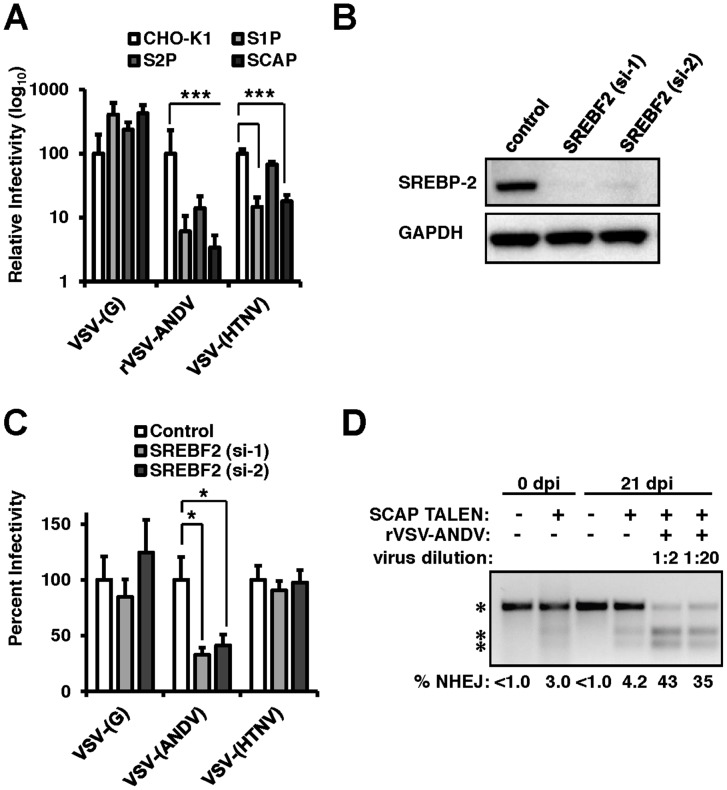
The sterol regulatory complex promotes infection of ANDV.(A) Infection of Chinese Hamster Ovary (CHO) cells null for S1P, S2P, or SCAP (Figure S2). CHO cells were infected with VSV-(G), rVSV-ANDV or rVSV-HTNV for 10 hours. Infections were quantified via flow cytometry and normalized relative to wild-type (CHO-K1) cells. Mean±SEM shown for three independent experiments; *** p<0.001. (Raw infection percentage (CHO-K1): VSV-(G) = 21%, rVSV-ANDV = 15%, VSV-(HTNV) = 8%) (B) siRNAs directed against SREBF2 efficiently knock down protein expression as measured by immunoblot to SREBP-2 with GAPDH as a loading control. (C) HEK293T cells depleted of SREBF2 were infected with non-replicating VSV pseudotypes bearing the indicated glycoproteins encoding red fluorescent protein (RFP) and infection was quantified 10 h.p.i.. Infectivity was normalized relative to control cells. Mean±SEM shown for three independent experiments; * p<0.05. (Raw infection percentage (control): VSV-(G) = 4%, VSV-(ANDV) = 19%, VSV-(HTNV) = 3%) (D) TALENs were used to genetically disrupt SCAP in HEK293T cells. These insertions were enriched upon challenge with rVSV-ANDV and were all killed by VSV-G. Enrichment was measured by a non-homologous end joining (NHEJ) endonuclease assay where a single band (top asterisk) indicates the presence of wild-type sequence and the lower molecular weight doublet (lower 2 asterisks) represents the disrupted alleles. Densitometry was used to quantify the levels of the undisrupted and disrupted alleles, which is shown below.